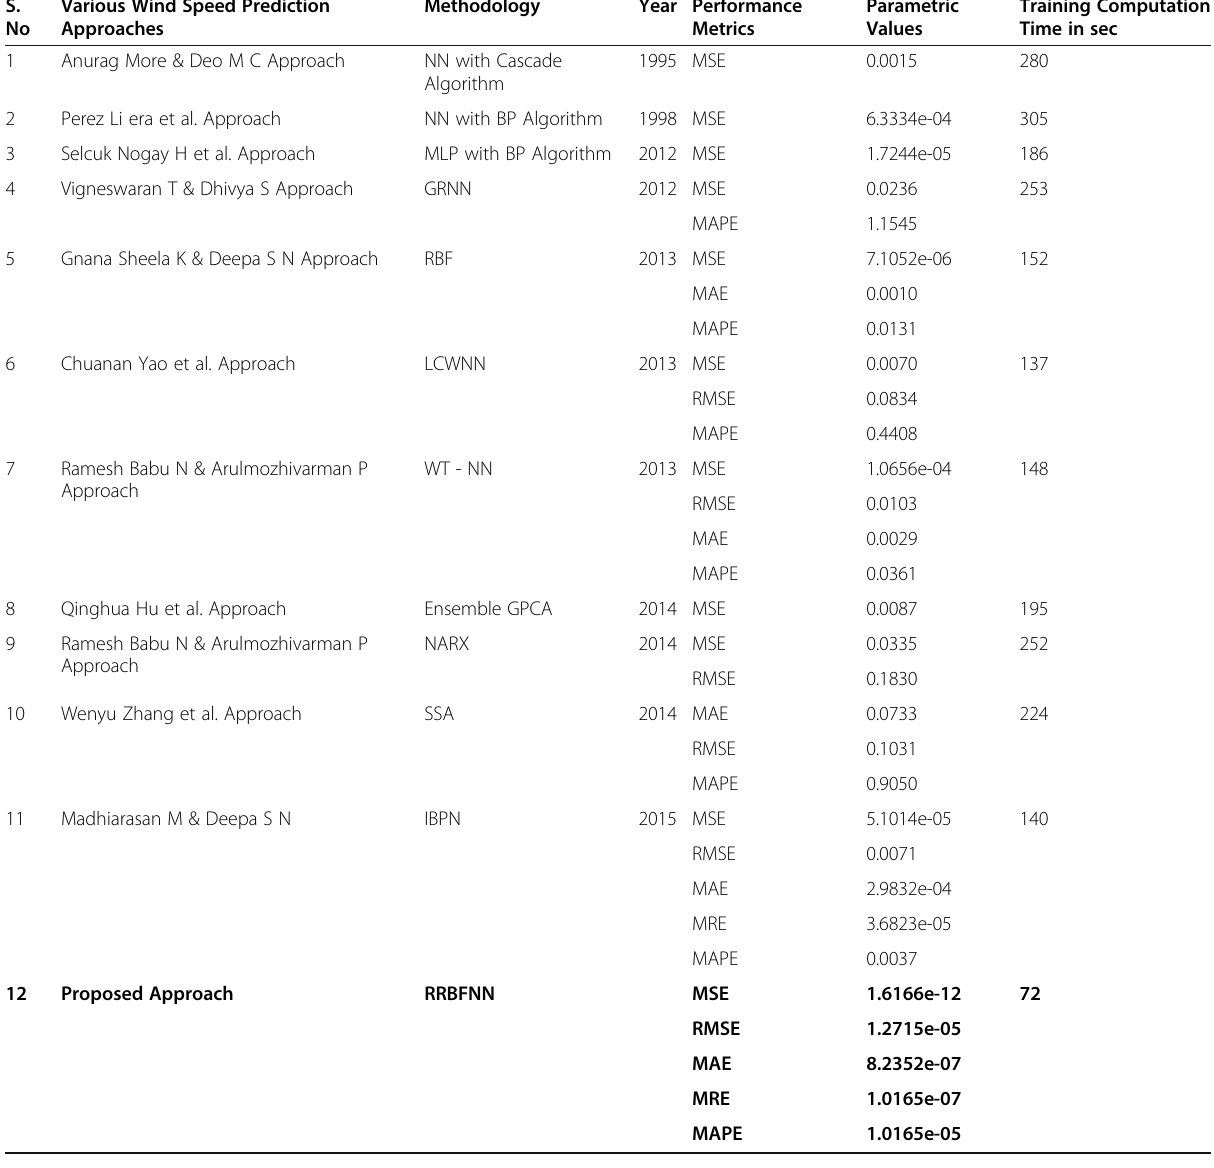
Table 7 Comparison of the different approaches